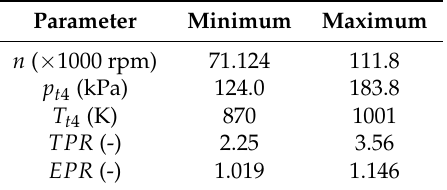
Table 2. Ranges of different engine